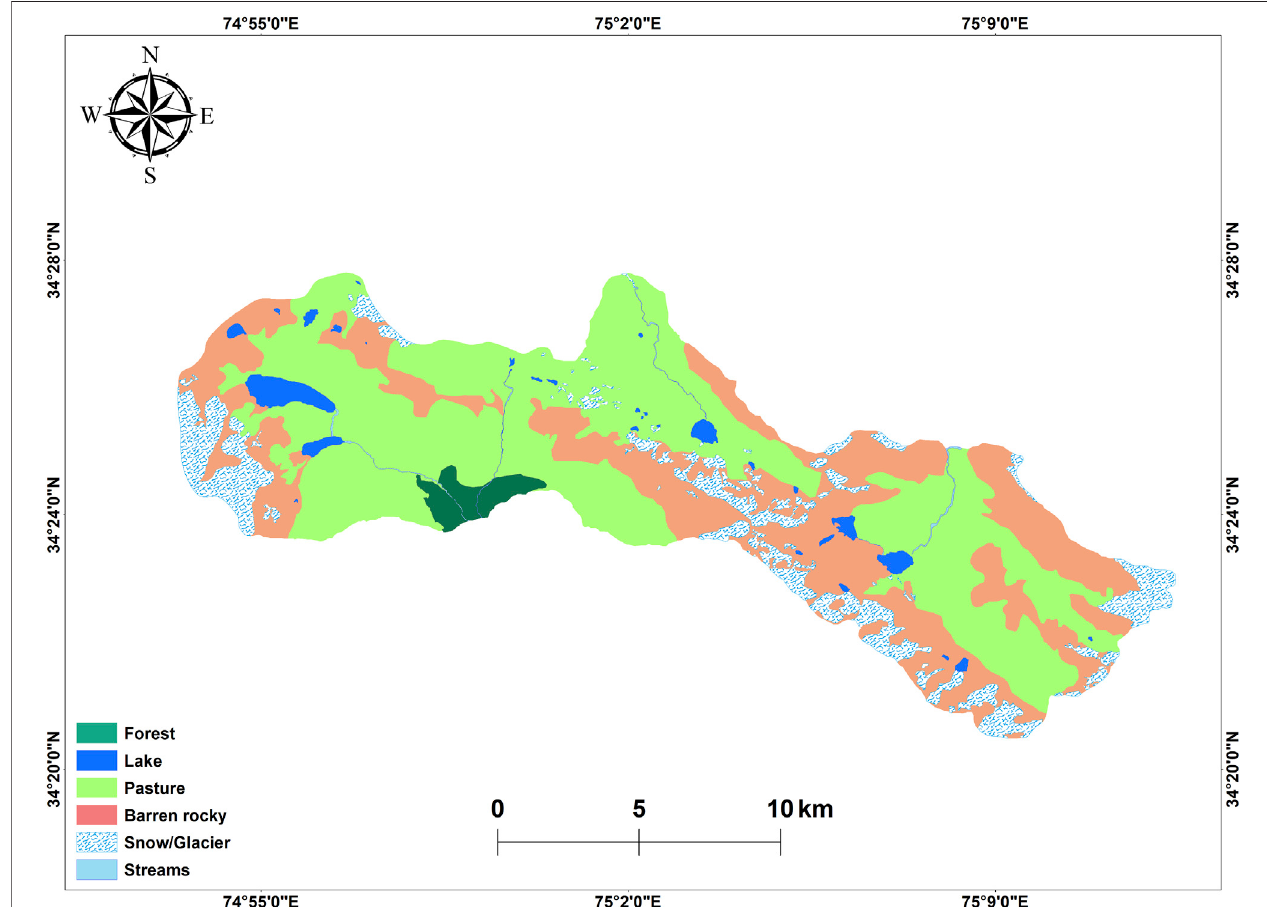
FIGURE 3 | Land use land cover (LULC) map of the catchment area of the lakes.